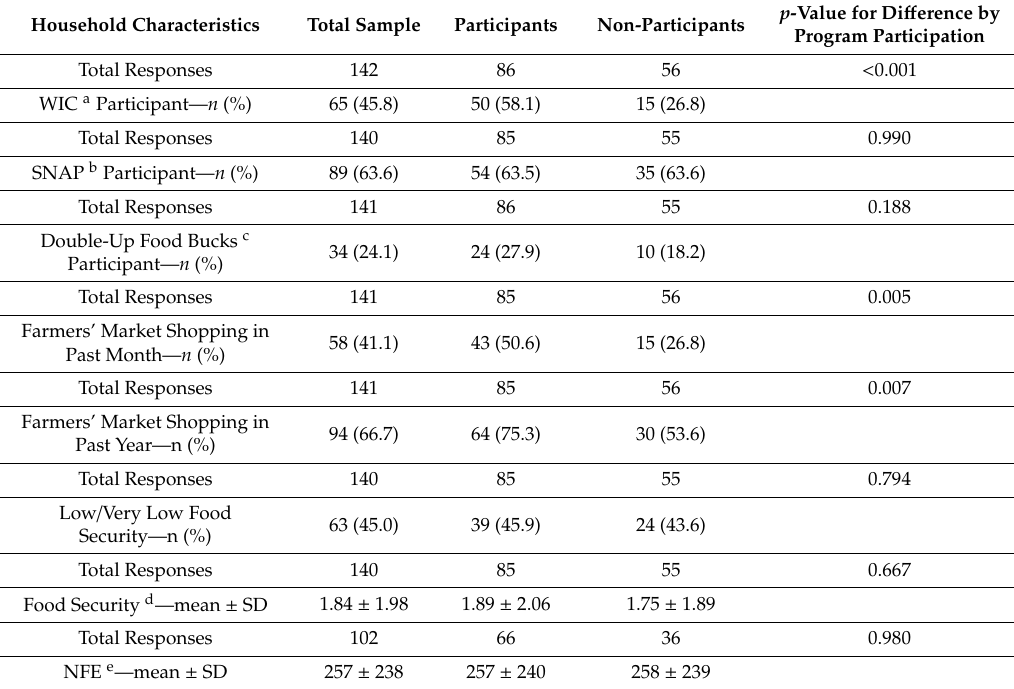
Table 3. Di ff erences in household characteristics between fruit and vegetable prescription program participants and